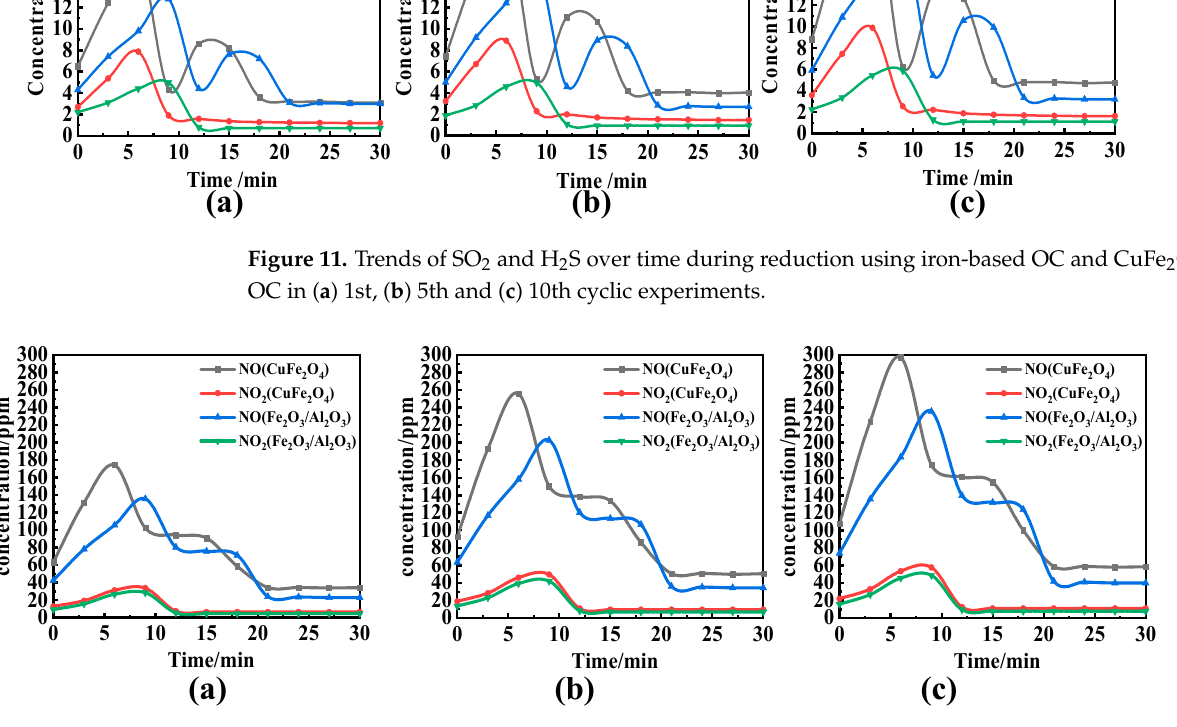
Figure 13. XRD patterns of ( a ) Fe 2 O 3 /Al 2 O 3 and ( b ) CuFe 2 O 4 in different cyclic experiments. Table 2. BET (Brunauer, Emmett, and Teller) specific surface area of CuFe 2 O 4 and iron-based OC after cyclic experiment. Sample